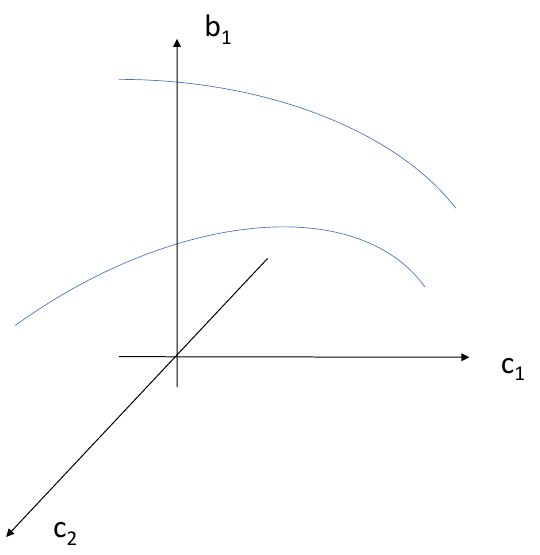
Figure 1 . A depiction of the reducible variety given by the system (2.15). This variety lives in the combined space of complex structure, c a , and source coe(cid:14)cients, b i , of the map P in (2.12).